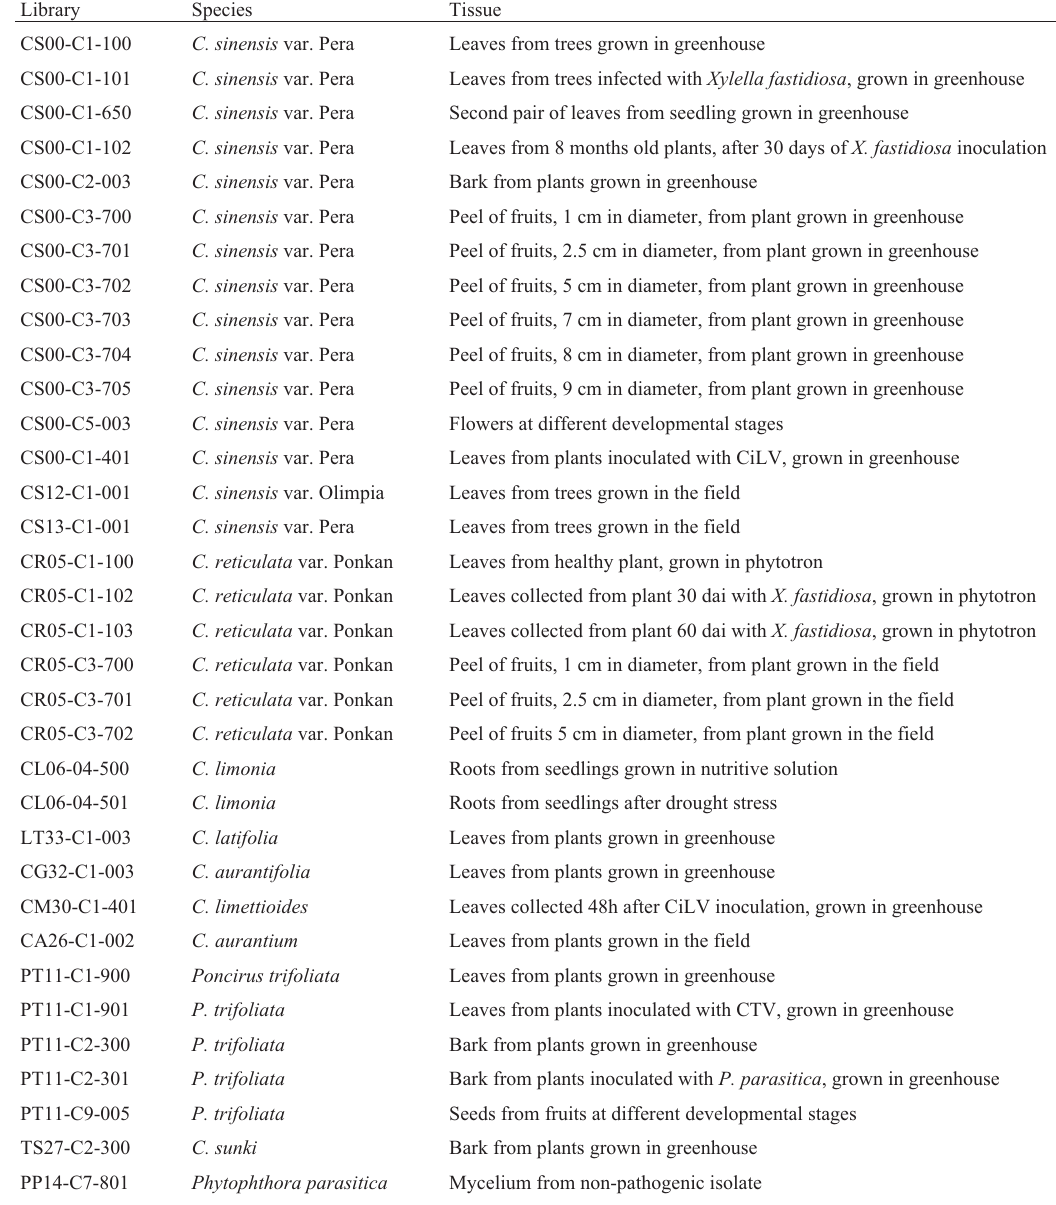
Table 1 - RNA sources used to construct the cDNA